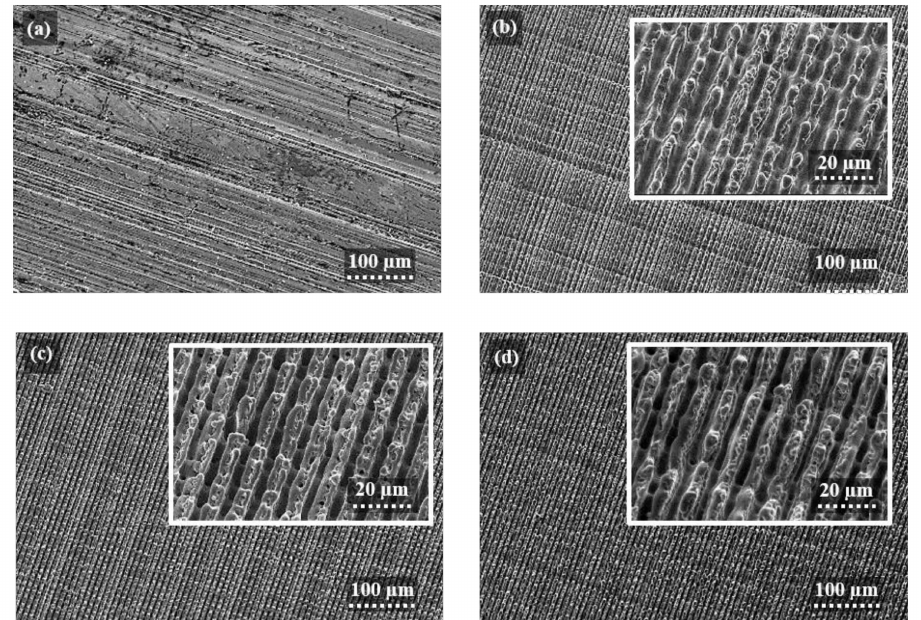
Figure 4. Scanning electron micrographs of initial surface topography ( a ), and the nanosecond DLIP structures produced on 100Cr6 steel using spatial period Λ = 8.50 µ m, and the corresponding processing parameters: F = 6.02 J / cm 2 , P O = 90.54%, H D = 58% ( b ), F = 6.02 J / cm 2 , P O = 98.52%, H D = 58% ( c ), and F = 6.72 J / cm 2 , P O = 98.52%, H D = 70% ( d ). The insets show the corresponding magnification